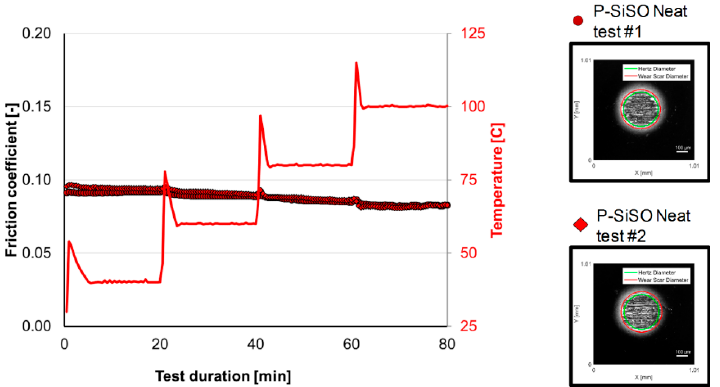
Figure 3. Results of V{150 N/40–100 °C/80 min} for two repeated tests with neat P-SiSO. Ball wear scars are shown as insets to the right.